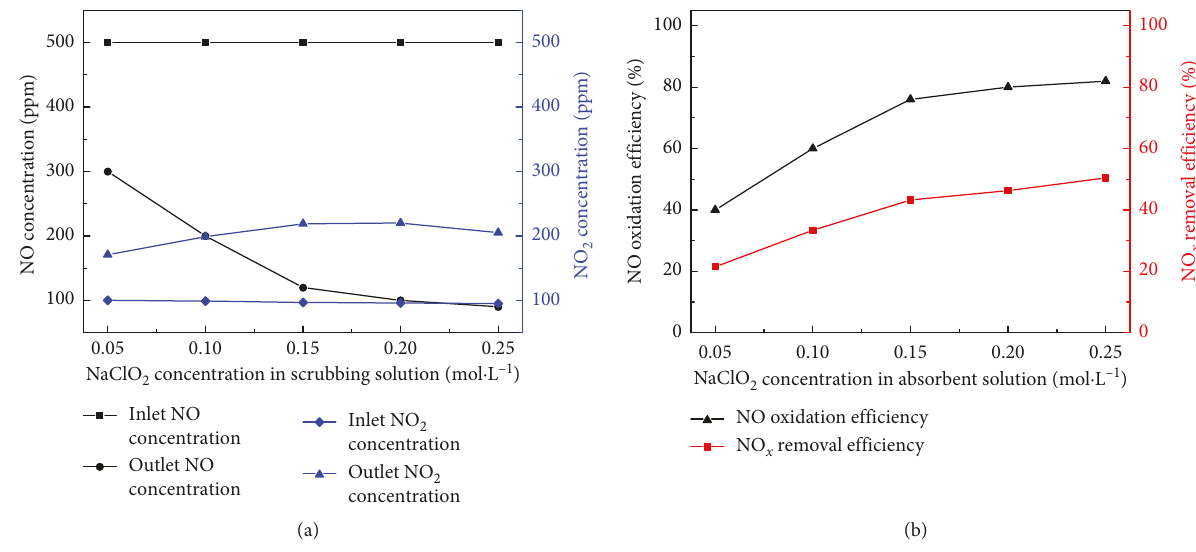
Figure 4: Changes of NO